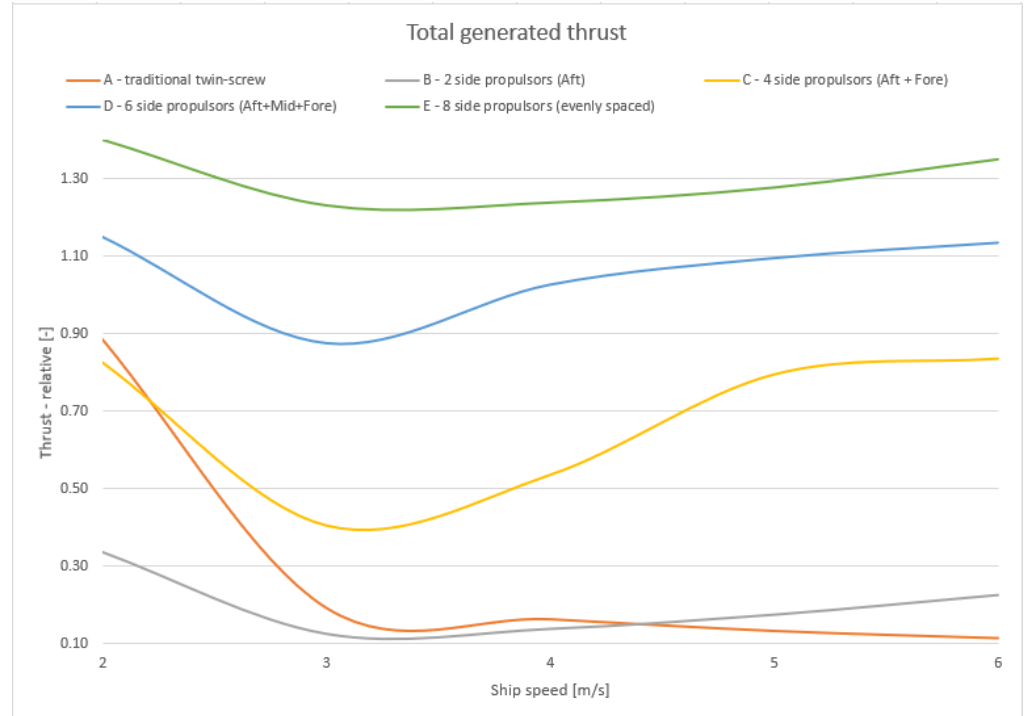
Figure 9. Total generated thrust, shallow water (comparison). Source: Authors. J. Mar. Sci. Eng. 2020 , 8 , x FOR PEER REVIEW